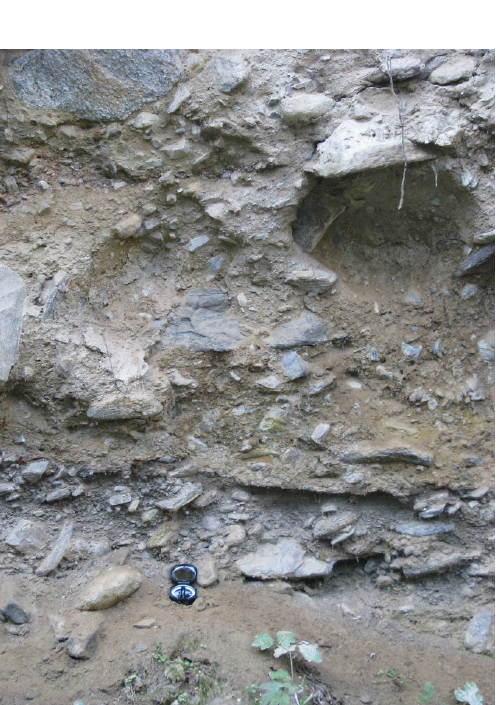
Figure 9. Soil material in the Linong Gully deposit.